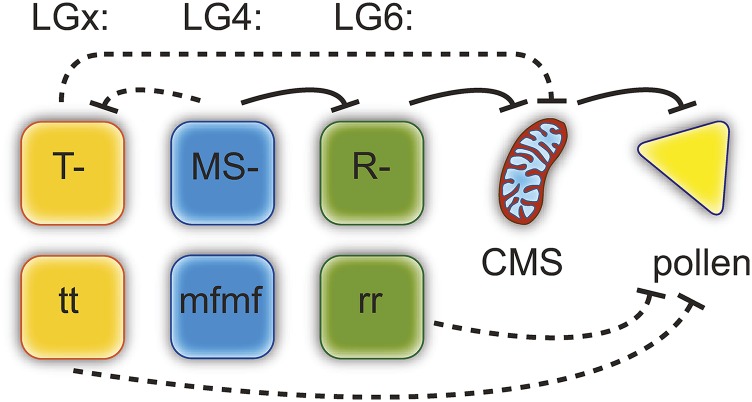
Conceptual model of male sterility loci in F. vesca subsp. bracteata. Black lines represent potential inhibitory interactions between genes. Dashed lines are uncharacterized genetically or posed as alternatives to the solid lines (see text). Three nuclear loci are represented by their known (LG4 and LG6) or unknown (LGx) location in the genome. The hypothesized involvement of these loci with a CMS locus that blocks pollen development. The LG6 locus (R/r) is a restorer locus at which one copy of a dominant allele is sufficient to block CMS and restore fertility; thus male sterility is recessive at this locus. The LG4 locus (MS/mf) is an inhibitor at which a single dominant allele is sufficient to block the LG6 restorer. Thus the MS allele is both dominant to mf and epistatically dominant to R. Homozygosity for the t allele at the third unmapped locus on LGx also leads to disruption of pollen production, or could act as a restorer (T allele) similar to the LG6 locus.